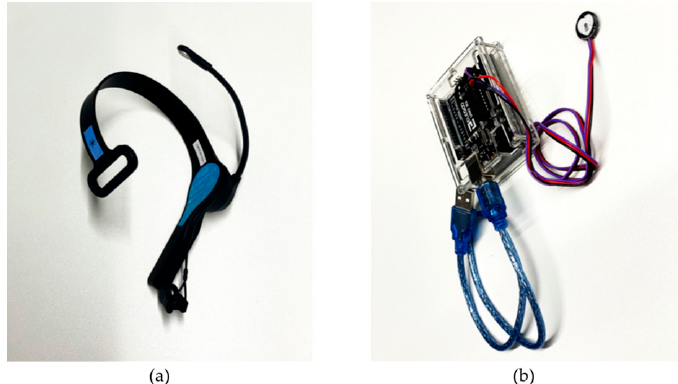
Figure 1. Biological sensors used in the experiment: ( a ) EEG sensor; ( b ) pulse sensor connected to Arduino board.